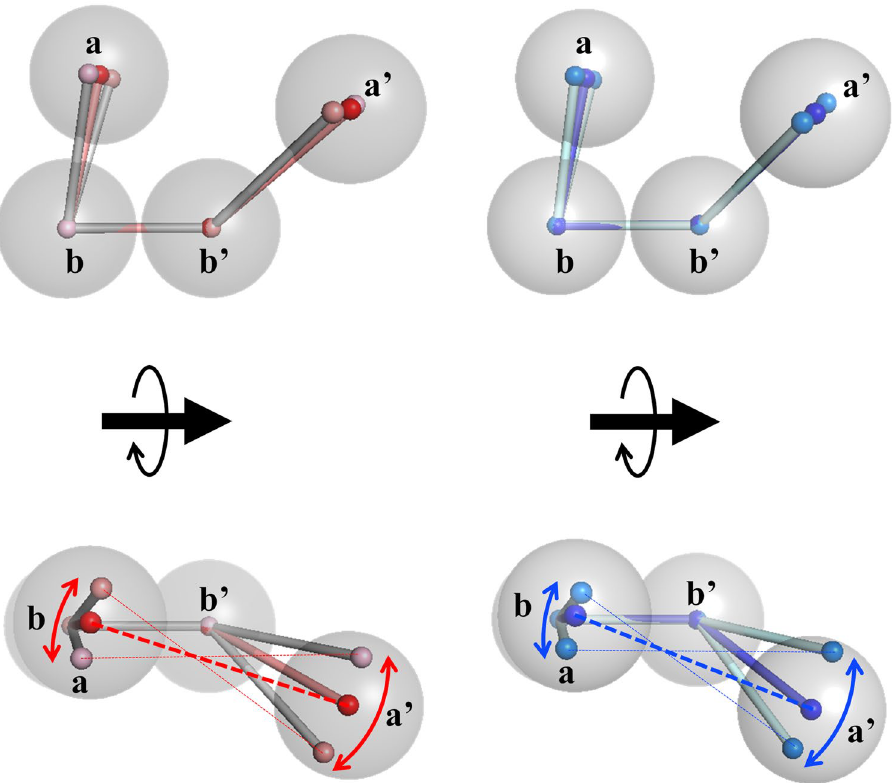
Figure 6. Conformational flexibility between the a and a ′ domains of ER-60. The conformational distribution of the domains is shown with red ball-and-stick models and with blue ball-and-stick models for ox- and red- models, respectively. The ox- and red-models are aligned by the b and b ′ domains. Gray balls roughly indicate domains as an eye guide. Coloured arrows indicate the expected ranges of flexibility in the a and a ′